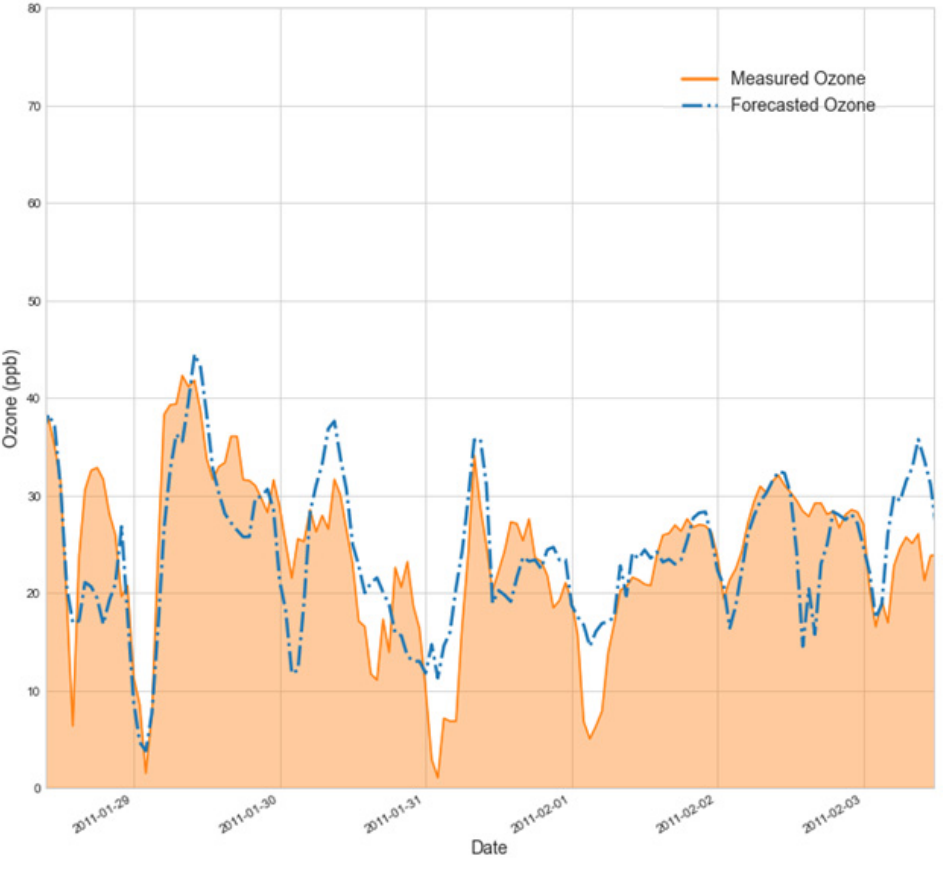
Figure 13. Comparison between forecast ozone values using GraphSAGE and validation dataset and actual measured concentrations for 6 h forecasting horizon.